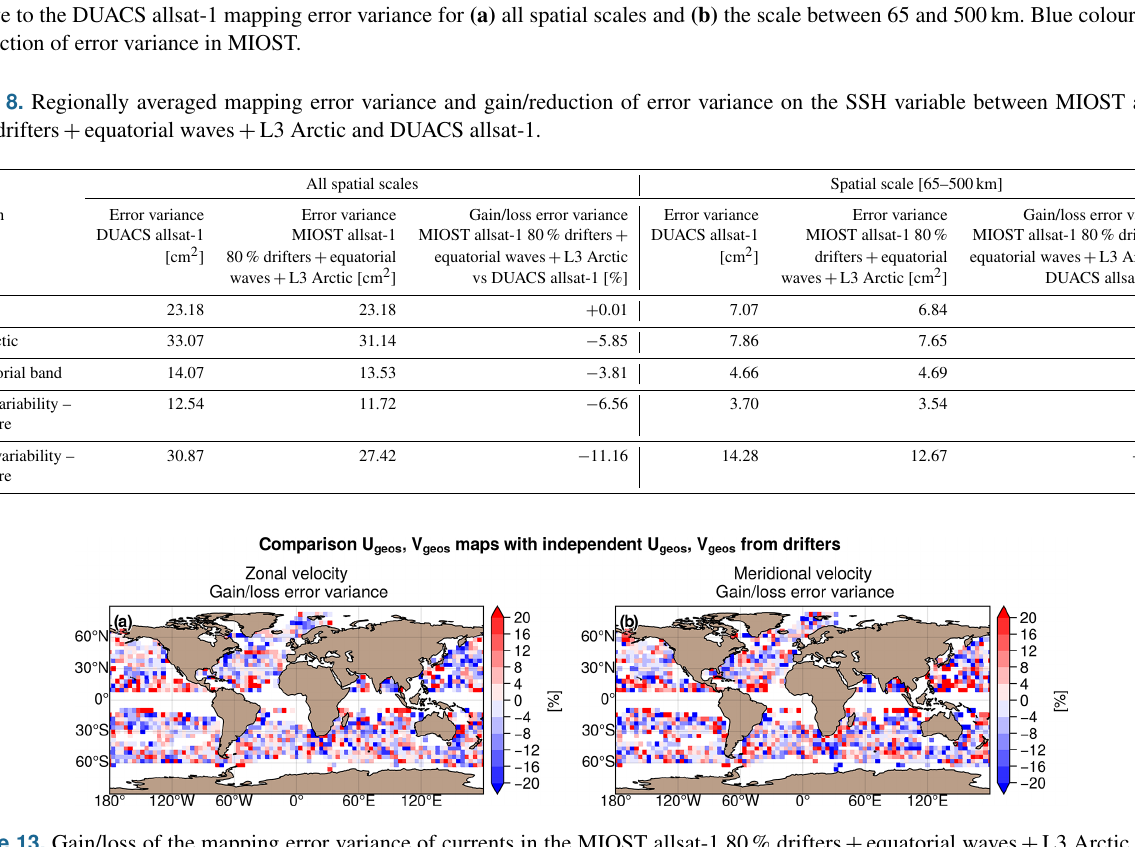
Figure 13. Gain/loss of the mapping error variance of currents in the MIOST allsat-1 80% drifters + equatorial waves + L3 Arctic experi- ment relative to the DUACS allsat-1 mapping error variance for (c) the zonal velocity component and (d) the meridional velocity component. Blue colour means a reduction of error in